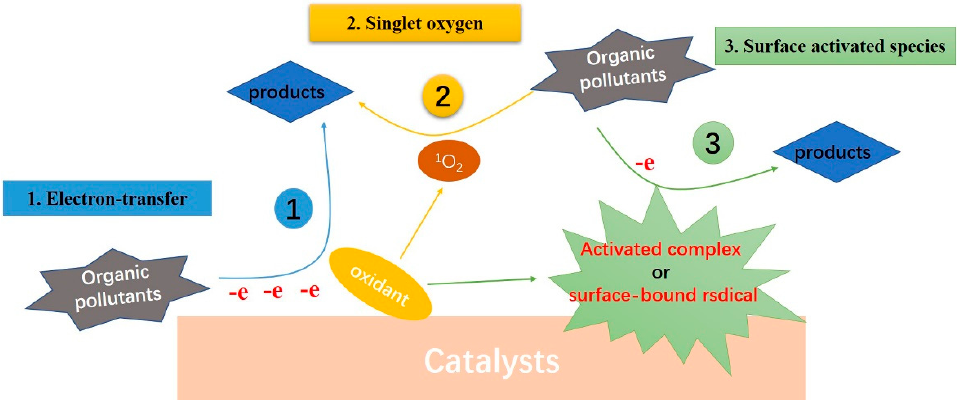
Figure 4. Schematic diagram of organic pollutants degradation by non-radical AOPs (Oxidant can be PMS, PS, H 2 O 2 or O 3 ).